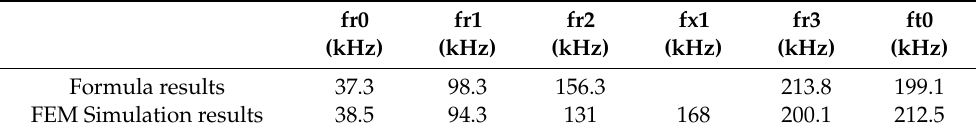
Table 1. Comparison of the FEM simulation results and calculation results with (2) and (3) of the resonance